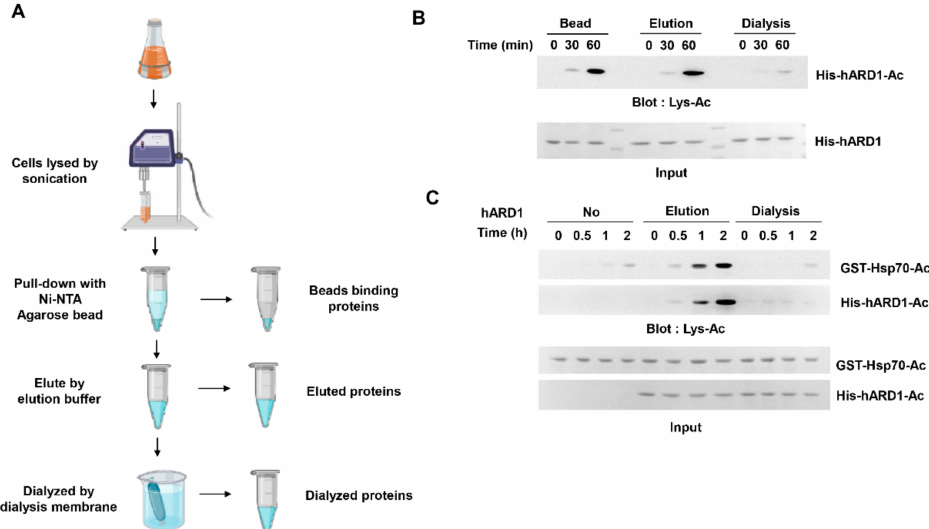
Figure 1. rhARD1 / NAA10 protein loses its KAT activity during dialysis. ( A ) Scheme of small-scale purification of hARD1 / NAA10. Ni-NTA agarose beads were incubated with lysates from harvested cells for 2 h, and the protein was eluted from beads with an elution bu ff er and subjected to dialysis with a dialysis membrane. ( B ) Autoacetylation activity of hARD1 / NAA10 is lost during dialysis. His-tagged hARD1 / NAA10 recombinants collected at di ff erent steps of purification were subjected to in vitro acetylation assays at indicated times, and autoacetylation level was analyzed with immunoblotting using an anti-Lys-Ac antibody. ( C ) The lysine acetyltransferase activity of hARD1 / NAA10 toward Hsp70 is lost after dialysis. In vitro acetylation assays of His-hARD1 / NAA10 and GST-Hsp70 at di ff erent time points were performed and assessed with western blotting using an anti-Lys-Ac